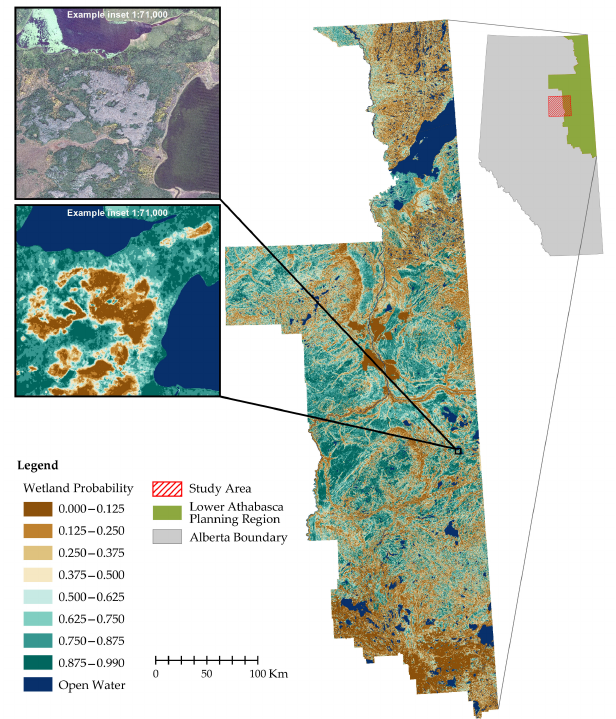
Figure 12. Showing application of the TOS model and resulting wetland probability of occurrence product for the Lower Athabasca Planning Region in northeastern Alberta, Canada. A close-up of a subset of the model output is shown alongside an equivalent true-color image of the same